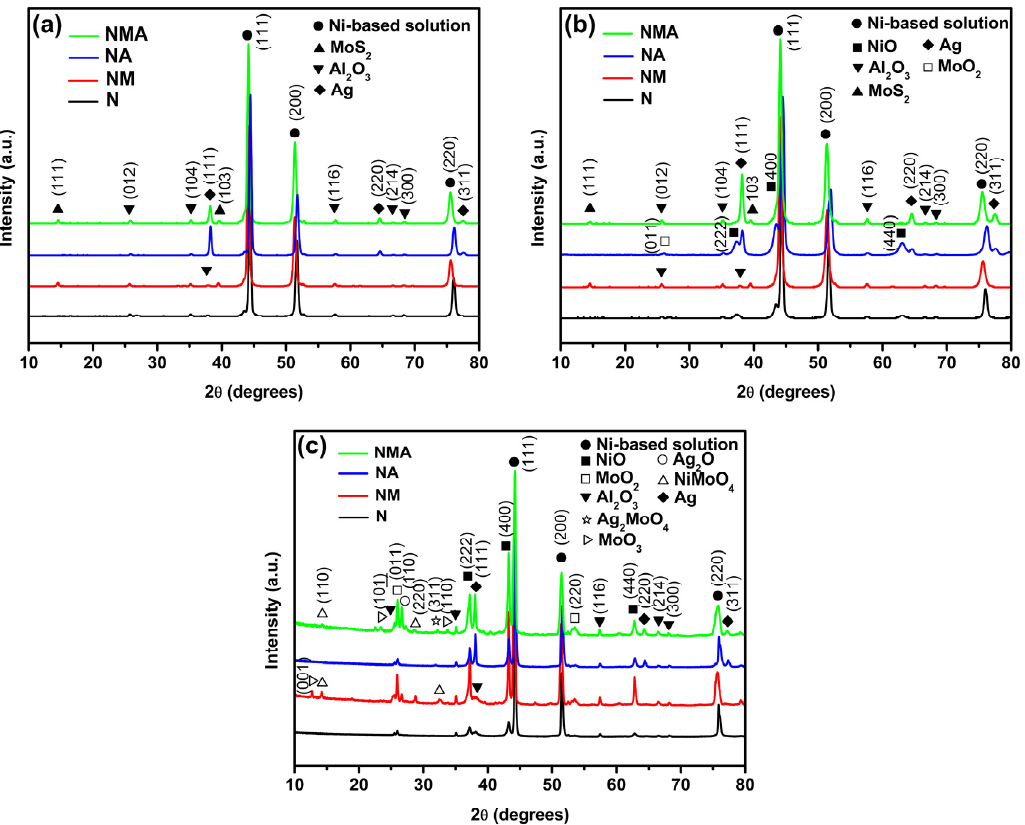
Figure 6. XRD patterns of the worn surface of a Ni-based composites test at ( a ) RT, ( b ) 400 °C, and ( c ) 800 °C.